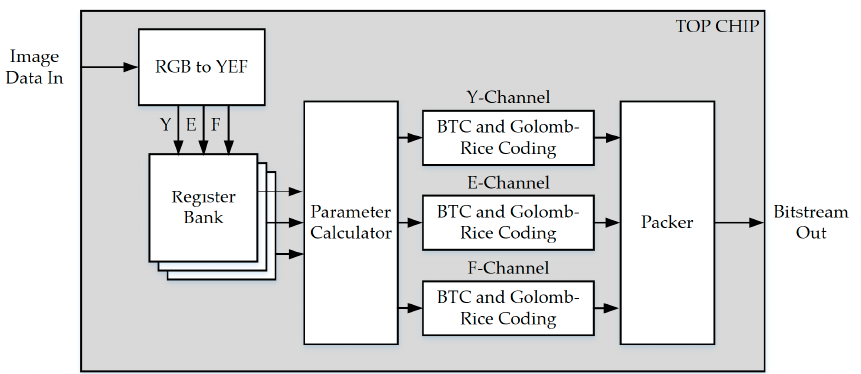
Figure 6. Block diagram of the proposed hardware architecture.